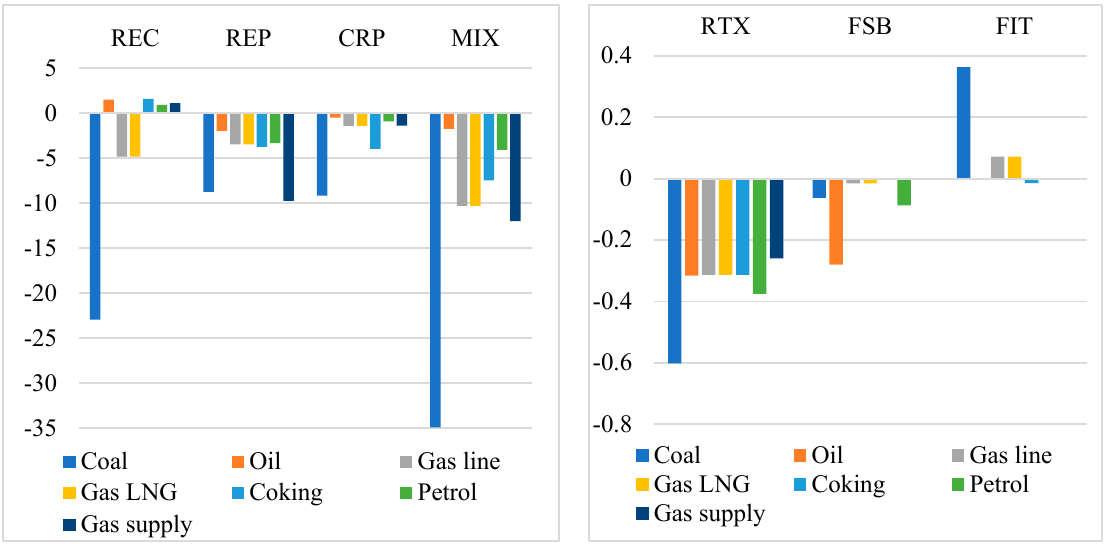
Figure 7. The accumulative changes in the output of fossil fuels in 2020–2060 relative to the baseline scenario (%). Source: CHINAGEM model simulation.